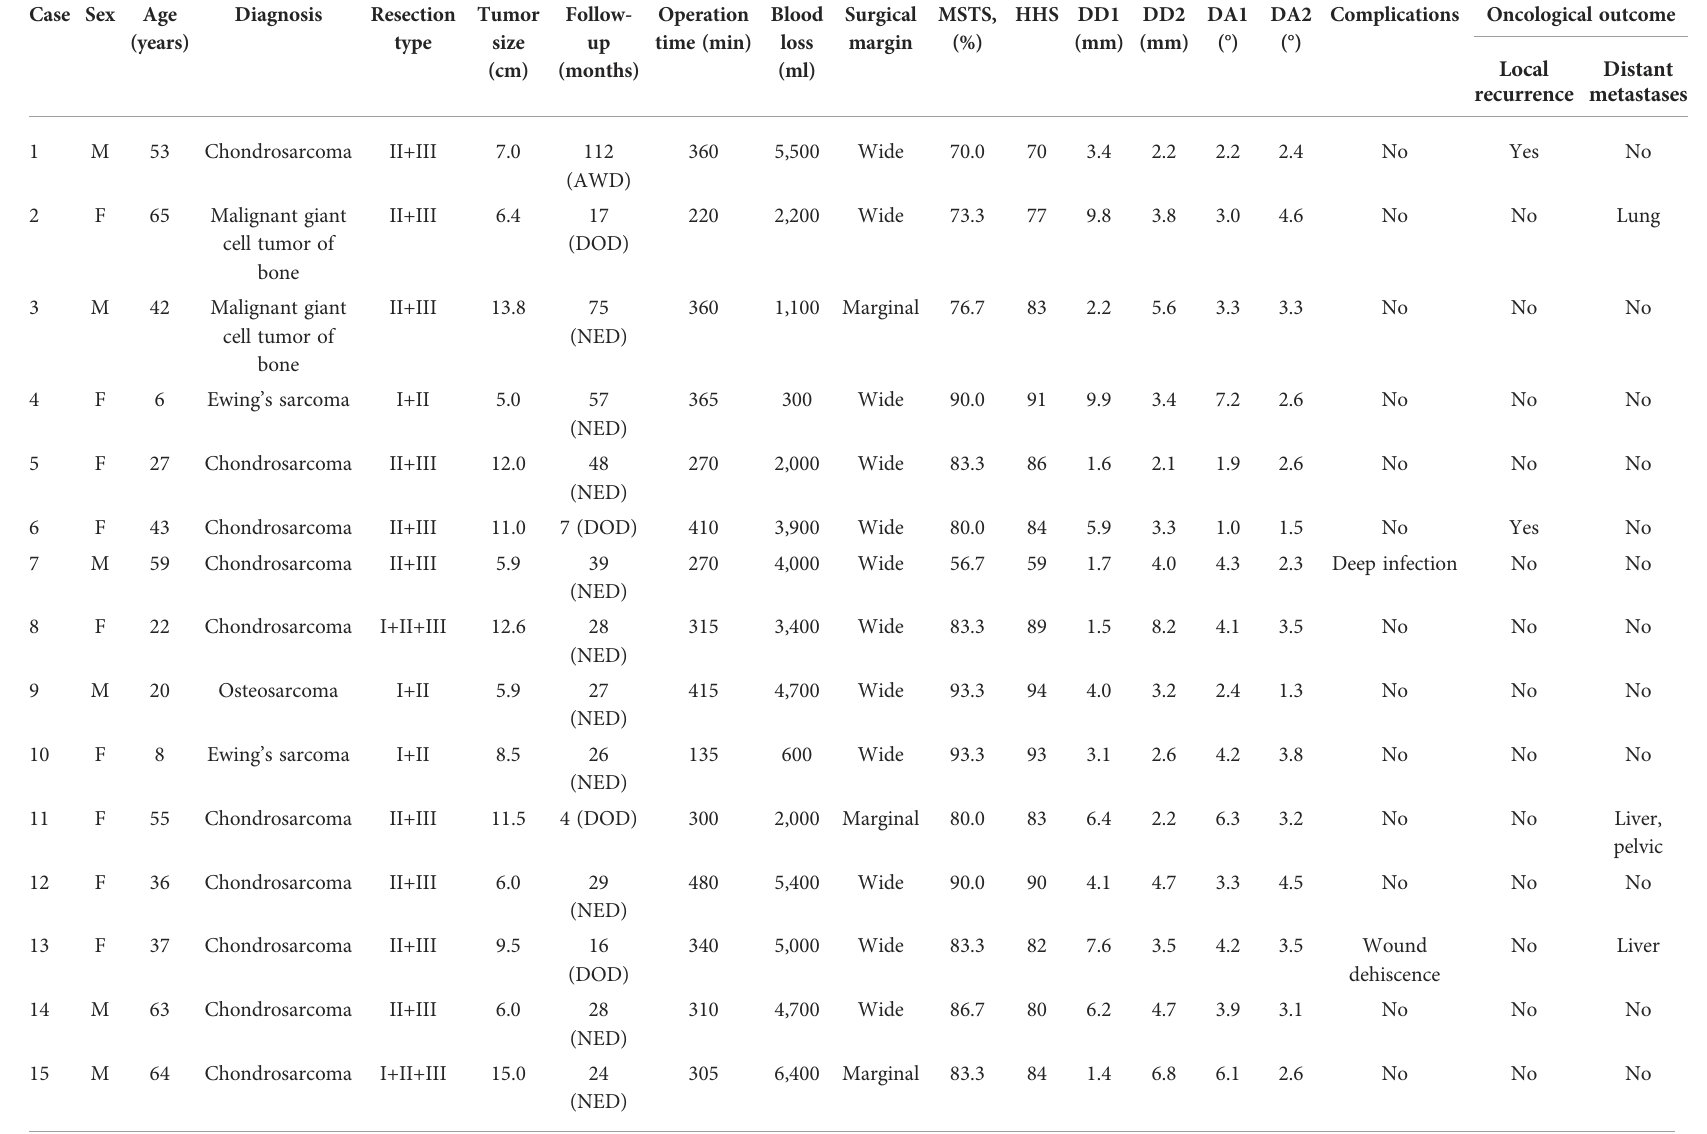
TABLE 1 Patient demographics and clinical data in the 3DP